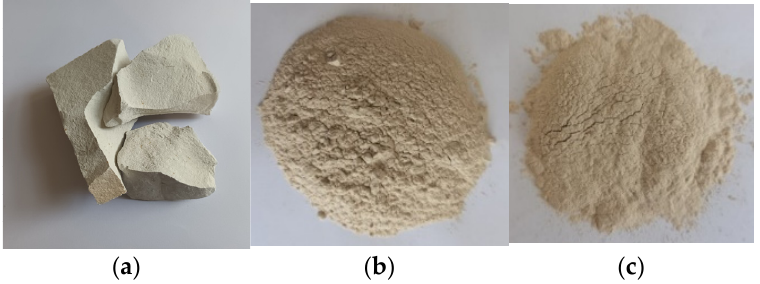
Figure 2. Zeolitic volcanic tuffs from the Valea Pomilor quarry before ( a ) and after micronization VP100 ( b ) and VP40 ( c ).